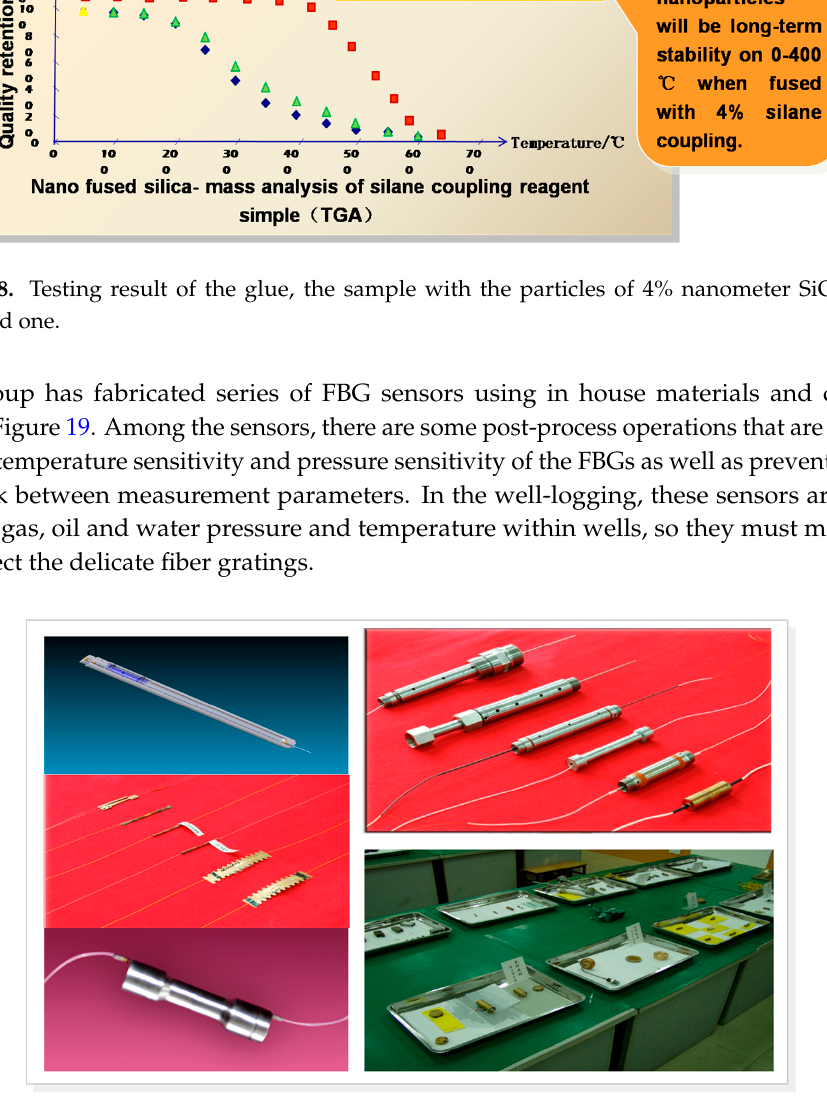
Figure 19. Series of FBG sensors, including strain sensors, high temperature sensors, high pressure sensors, and accelerometers.